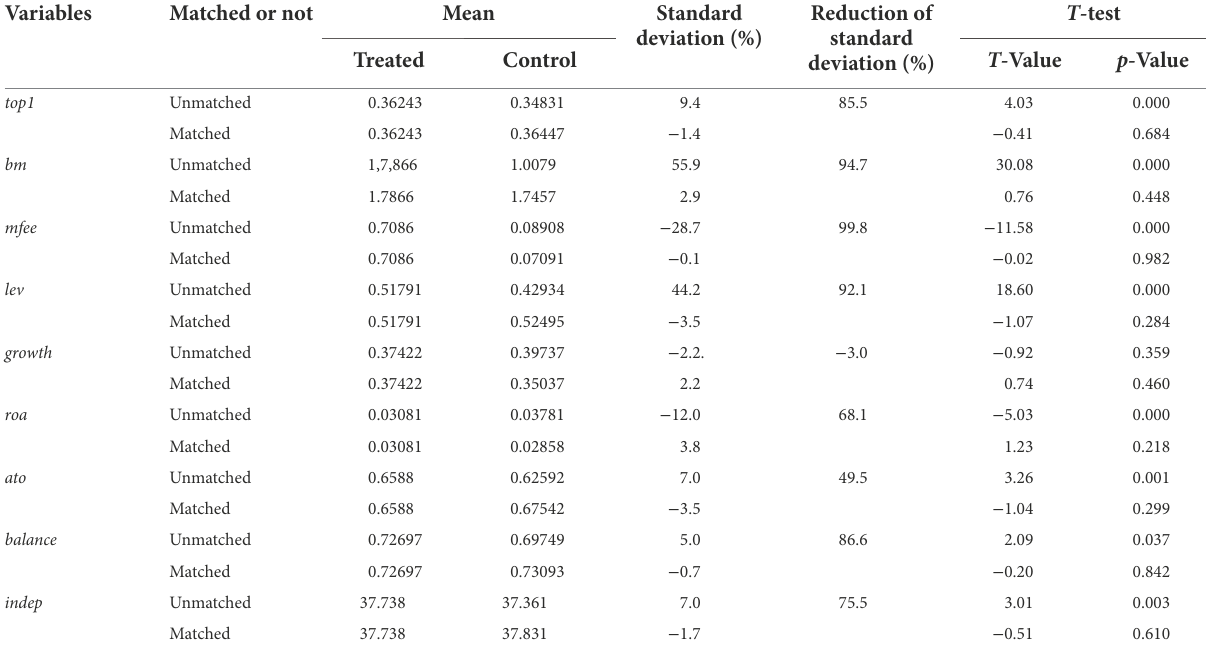
TABLE 5 Matching variable balance test